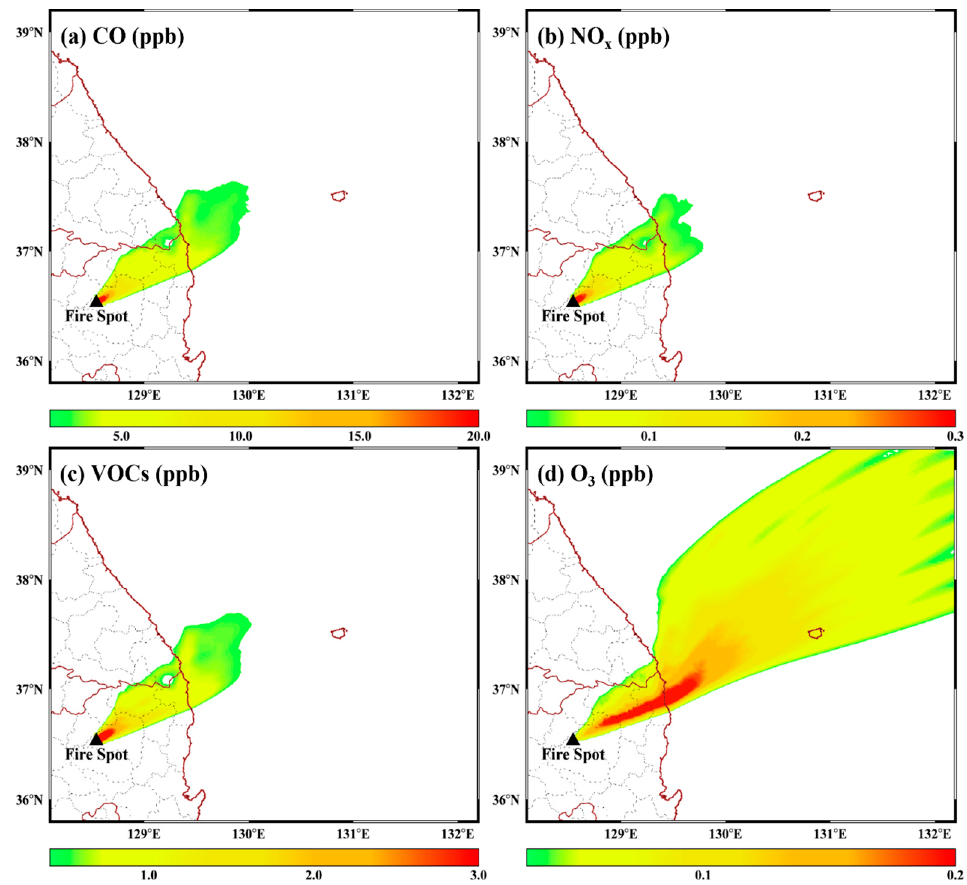
Figure 6. Horizontal distribution of changes in concentration of primary pollutants (( a ) CO, ( b ) NO x , ( c ) VOCs) and ( d ) O 3 due to Andong wildfire (FINN_pbl—BASE). The concentration change values are the averages from the ground surface to the top of the plume from 09 to 17 LST on 25 April 2020.